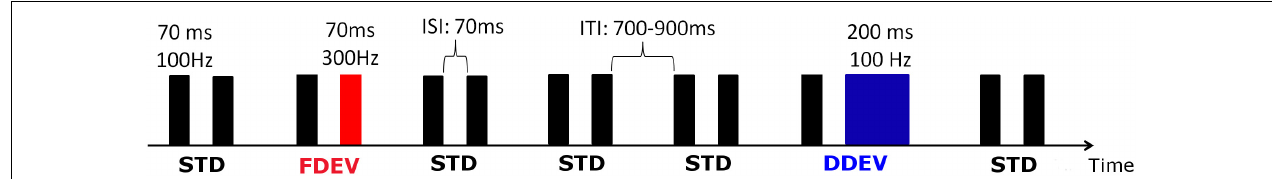
FIGURE 1 | Schematic representation of the auditory oddball paradigm. STD stimuli (black) were composed of two identical tones [F0 = 100 Hz, duration = 70 ms, inter-stimulus interval (ISI) 70 ms], whereas in the deviant stimuli (DEV), the second tone had a fundamental frequency of 300 Hz (FDEV, in red) or it lasted 200 ms (DDEV, in blue). Inter-trial interval (ITI) varied randomly from 700 to 900 ms. In each session, 1200 stimuli (80% STD, 10% FDEV, 10% DDEV) were delivered in pseudo-random order with the constraint of at least three STD stimulus presentations between DEV pairs.